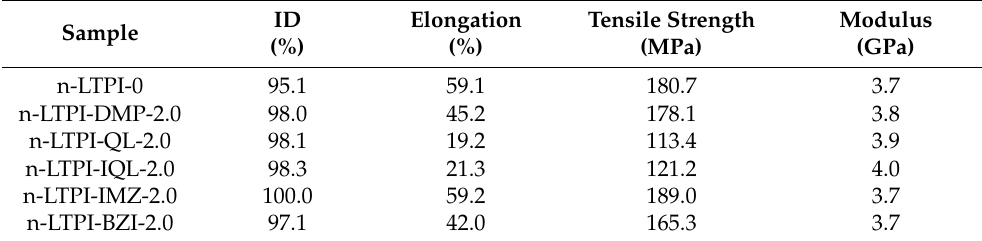
Table 2. Mechanical properties of the thermally cured n-LTPI films at 230 ◦ C/2 h with different heteroaromatic bases as curing catalysts.